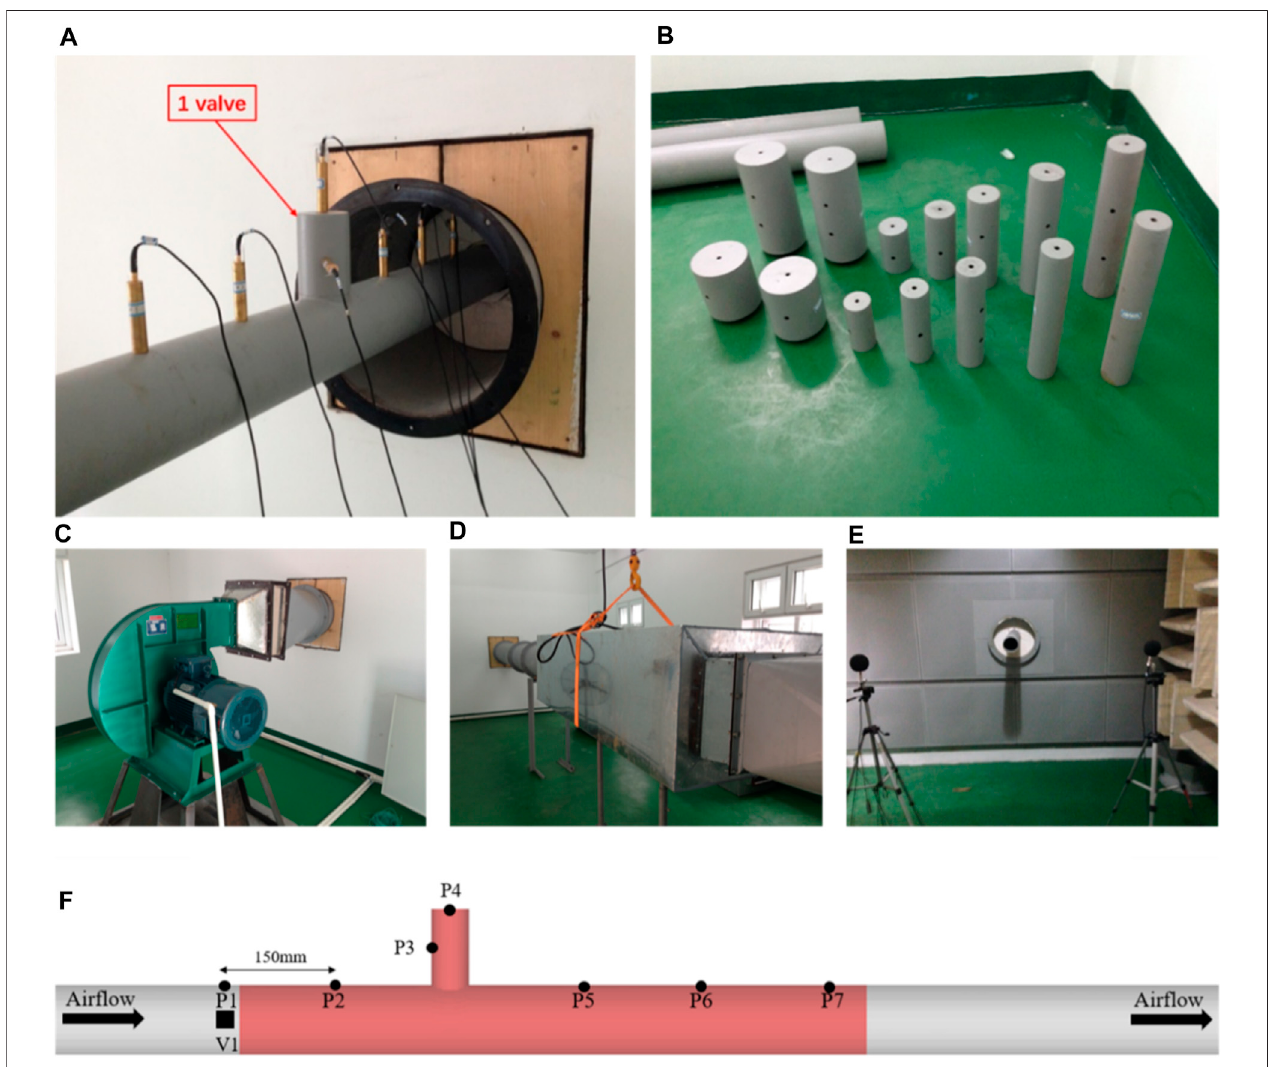
FIGURE3| Thenoisetestoftheresonantpipeline-cavitysystem: (A) Singlepipevalveacoustictestingsystem; (B) multipletypesofvalveresonators; (C) theair fl ow generation system; (D) the muf fl er in front of the testing system; (E) semi-anechoic room in the end; (F) Pressure fl uidization and velocity monitors in CFD model.